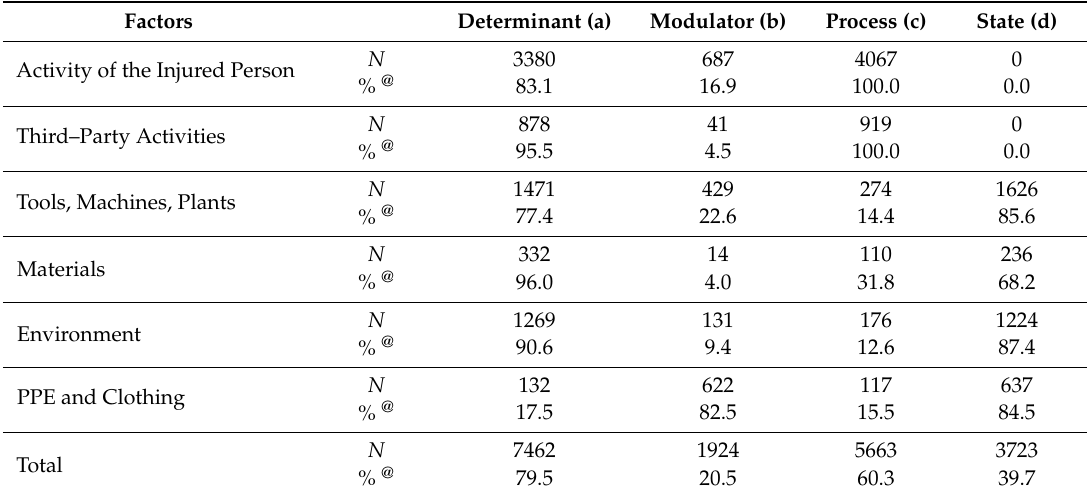
Table 5. Distribution of contributing factors for fatal work accidents according to their role played in the accident dynamics. Number ( N ); row percentage (%).